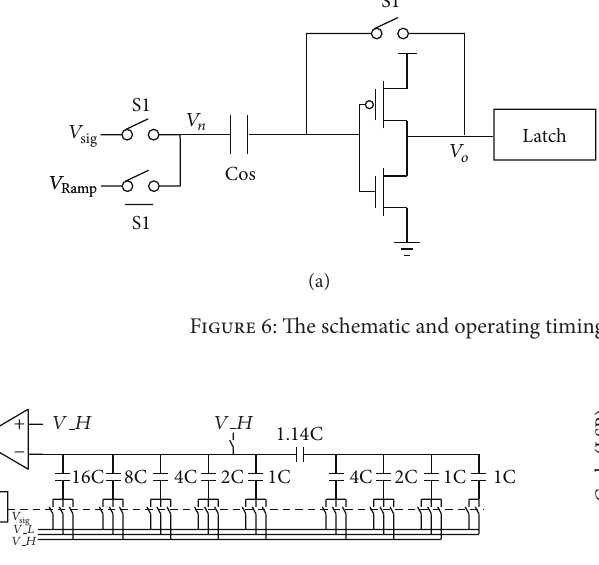
Figure 7: The schematic of the SAR ADC.